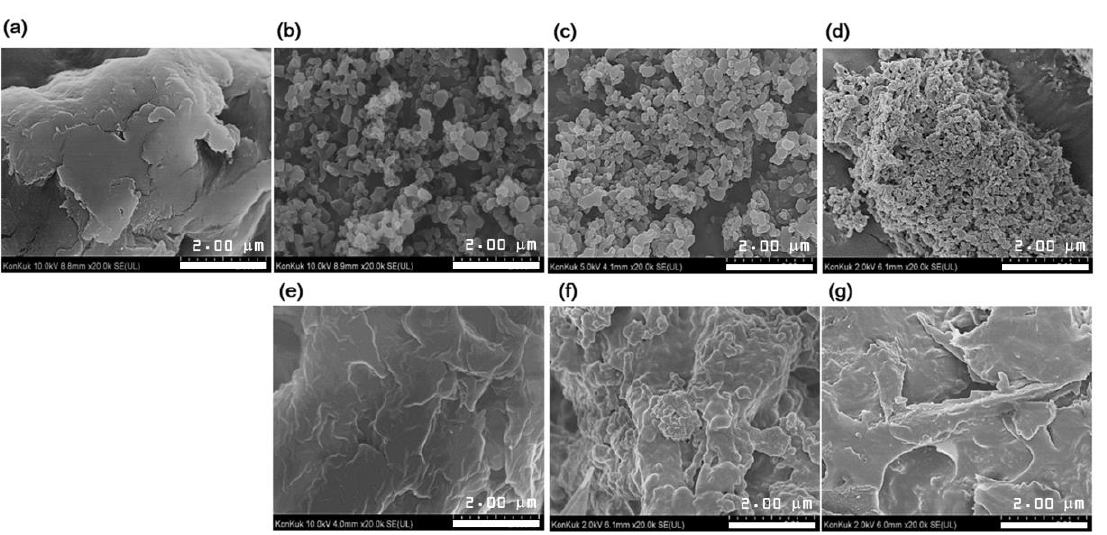
Figure 6. SEM images of cellulose ( a ); Bz–Cell ( b ); Bz–Cell after adsorption with phenanthrene ( c ); Bz–Cell after adsorption with pyrene ( d ); St–Cell ( e ); St–Cell after adsorption with phenanthrene ( f